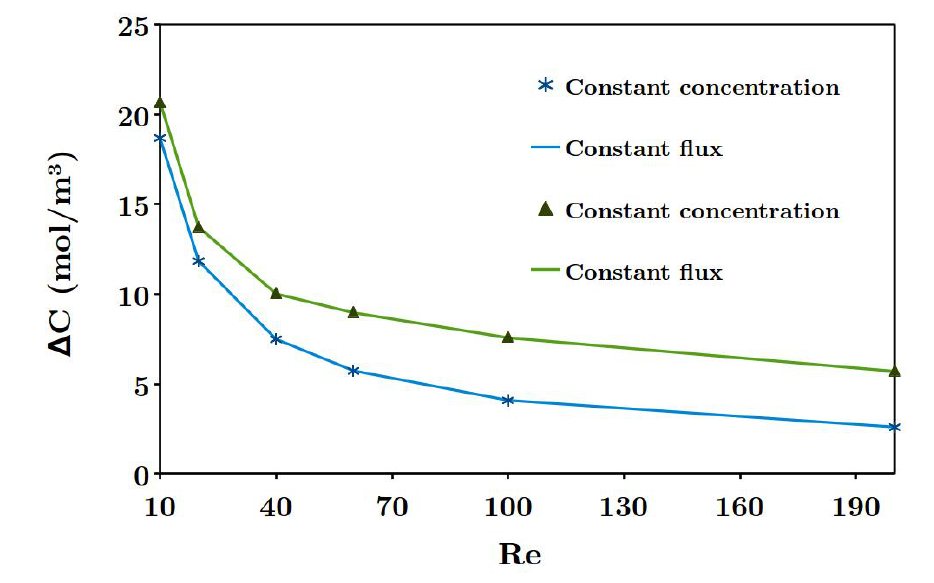
Figure 15. Concentration turnover ∆ C for flat channel and membrane with triangular corrugations with constant concentration and -flux boundary conditions.